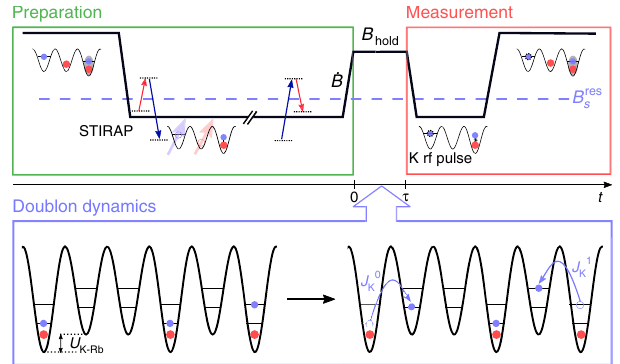
Figure 1 | A schematic of the experiment. Starting with a mixture of K, Rb and doublons (the smaller blue ball, the larger red ball and the pair grouped with grey background, respectively) in a 3D lattice, we sweep the magnetic field from above the s -wave Feshbach resonance (at B res 54 : 66mT) to s ¼ below the resonance to create Feshbach molecules. These molecules are then transferred to their ro-vibrational ground state via STIRAP (stimulated Raman adiabatic passage). After unpaired atoms are removed with resonant light, the STIRAP process is reversed to transfer the ground-state molecules back to Feshbach molecules. The field is then swept above B res to dissociate s the molecules and create doublons. After holding for a time, t , at B hold , we measure the conversion efficiency when sweeping the field below B res to s re-form Feshbach molecules. To detect molecules, we use a rf pulse to spin flip the unpaired K atoms to a dark state (ball with black dashed edge) before dissociating the Feshbach molecules and imaging K atoms. The bottom panel illustrates possible dynamics of the doublons during B hold . As shown schematically, lattice sites populated with a K and a Rb atom have an interaction energy shift U 0 . The K tunnelling energies in the lowest and first KRb and J 1 , respectively. Rb tunnelling happens excited bands are denoted by J 0 K K at a slower rate since it experiences a deeper